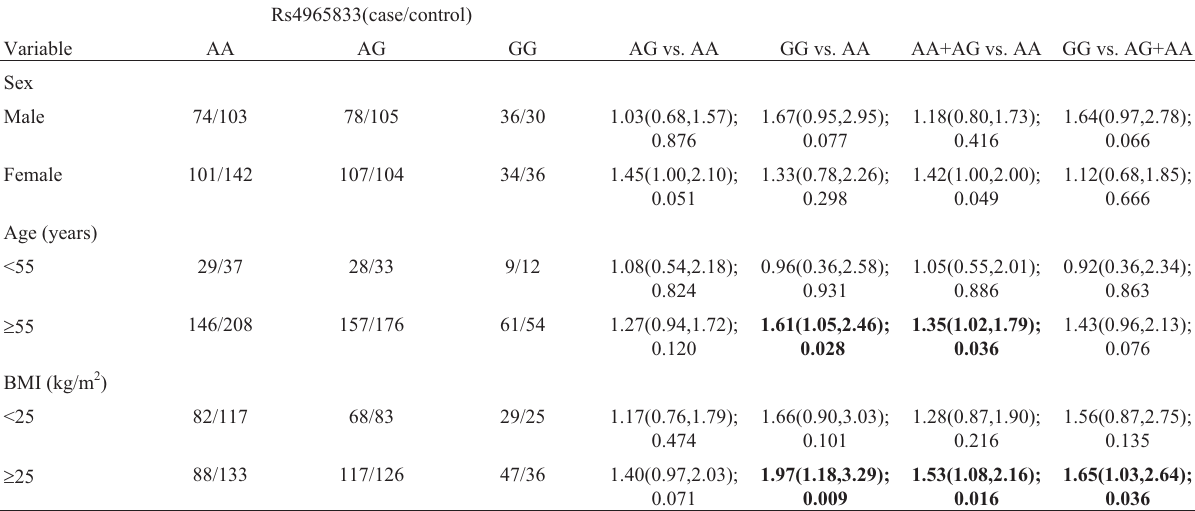
Table 4 - Stratified analyses between PACE4 rs4965833 polymorphism and the risk of osteoarthritis.